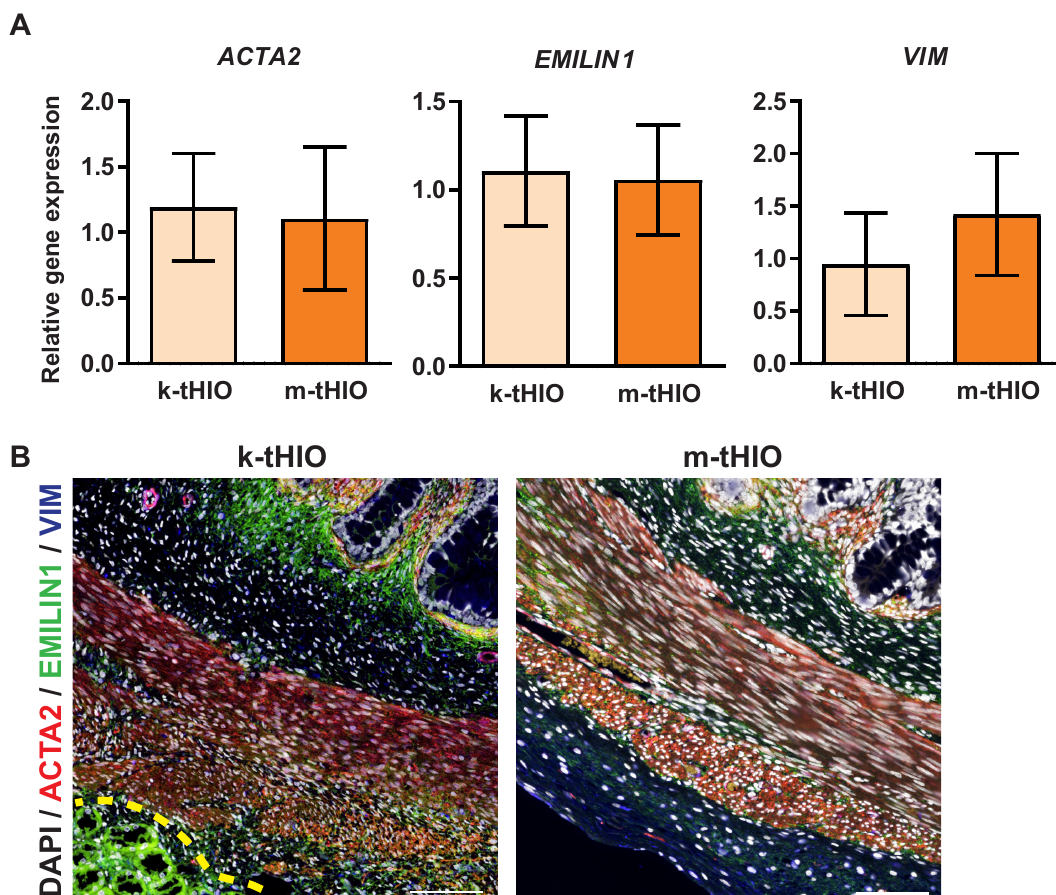
Fig 4. Grafts harvested from both sites developed mesenchyme. (A) Relative gene expression in k-tHIO and m-tHIO for mesenchymal components by ACTA2, EMILIN1, and VIM. For k-tHIO, n = 7 and for m-tHIO n = 5; p = n.s. for all. (B) Protein level expression, by immunofluorescence, in k-tHIO and m-tHIO associated to transcripts in A. Scale bars = 100 μ m. Yellow dashed line indicates kidney